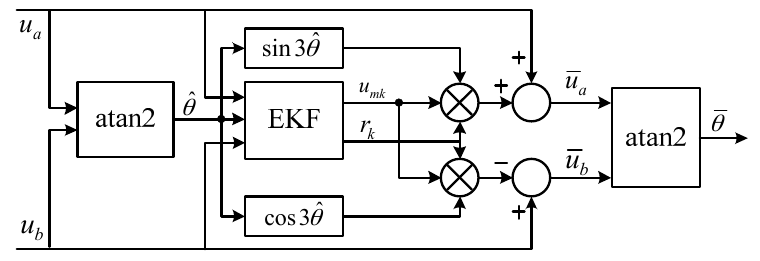
Figure 5. Diagram of EKF processing.